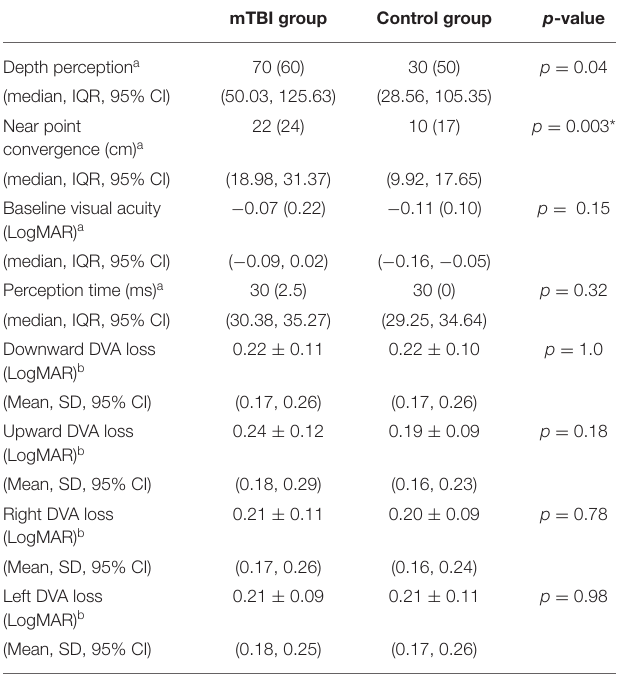
TABLE 2 | Differences between the mTBI and control groups in visual and vestibular outcomes. mTBI group Control group p